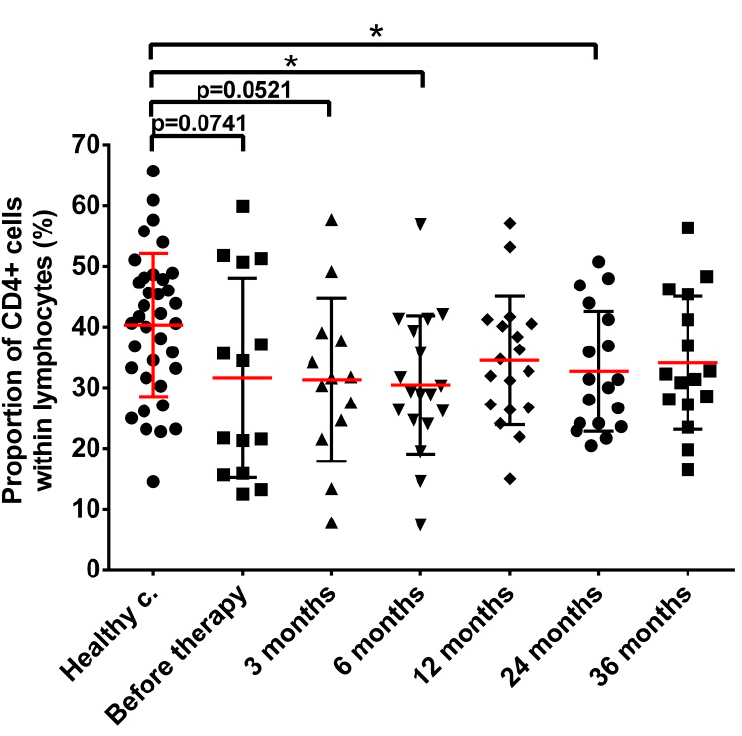
3.2. Low Dose Rate Brachytherapy Induces Persistent Changes in the Distribution and Phenotype of Several PBMC Subpopulations in Prostate Cancer Patients Therapy-related changes in the cellular immune parameters of low-dose rate brachytherapy- treated prostate cancer patients were investigated by immune phenotyping of the PBMCs before therapy and 3, 6, 12, 24, 36 months after seed implantation and were compared to the immune phenotype of healthy controls. For certain patients not all investigated immune cell phenotypes are available for all interim follow-up periods due to the insufficient PBMC yield in some of the collected blood samples. The fraction of CD4+ T cells within the lymphocyte population of prostate cancer patients was moderately lower than in healthy controls throughout the whole follow-up but interindividual variation was high. A statistically significant difference was only seen in prostate cancer patients 6 and 24 months after implantation of the radiation source (Figure 1).